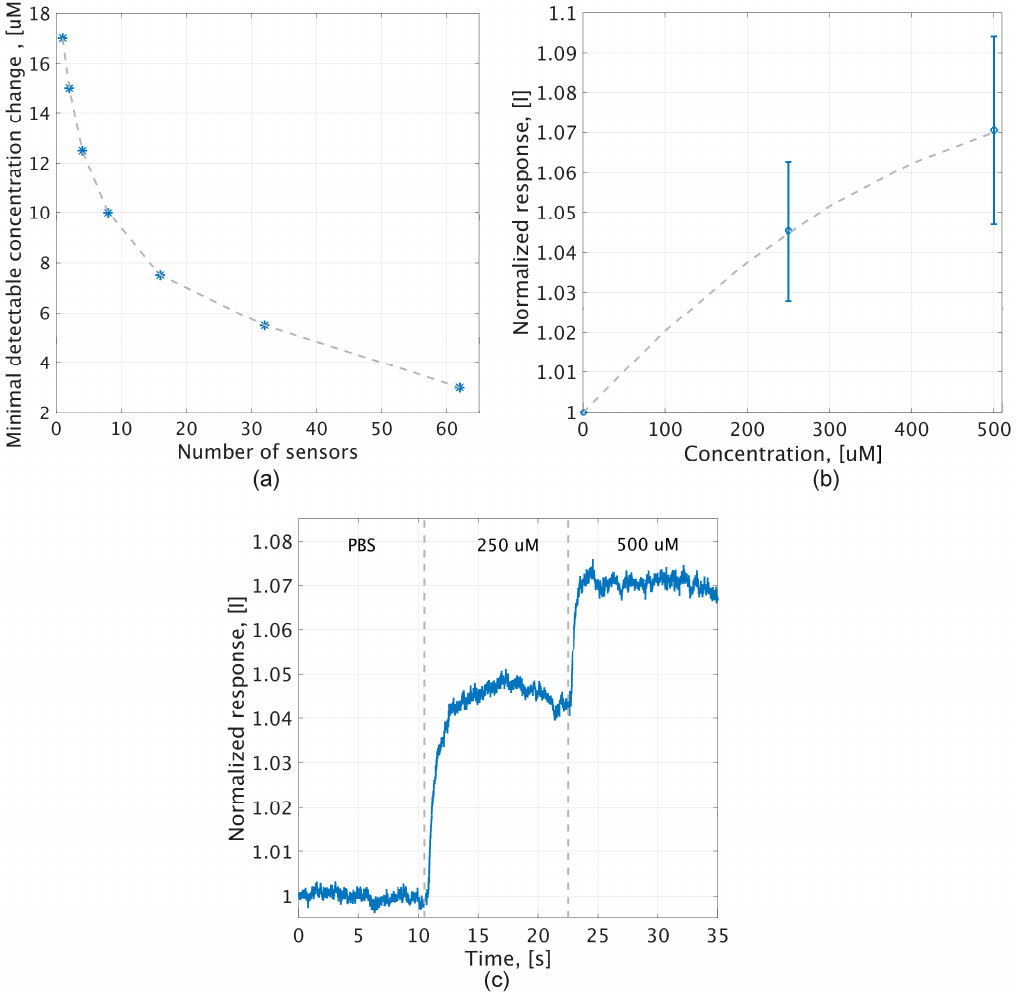
Figure 9. ( a ) Scaling of the minimal resolvable l -glutamate concentration with the number of used CNTFET devices; ( b ) Calibration curve of 62 devices. The relative non-linearity amounted to 3%; ( c ) Normalized, averaged current response, [I], of 62 CNTFET devices upon applying l -glutamate solutions of di ff erent